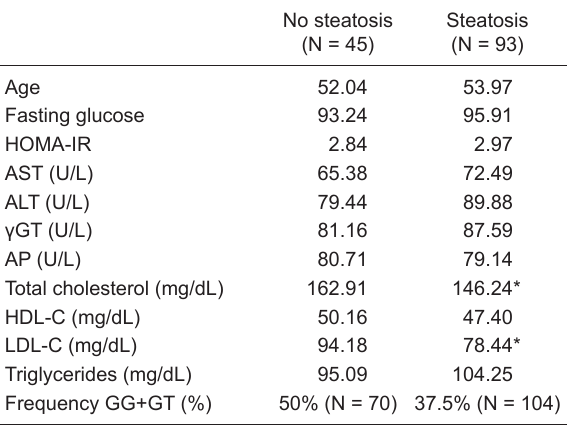
Table 3. Clinical and biochemical characteristics of chronic hepa- titis C patients according to steatosis